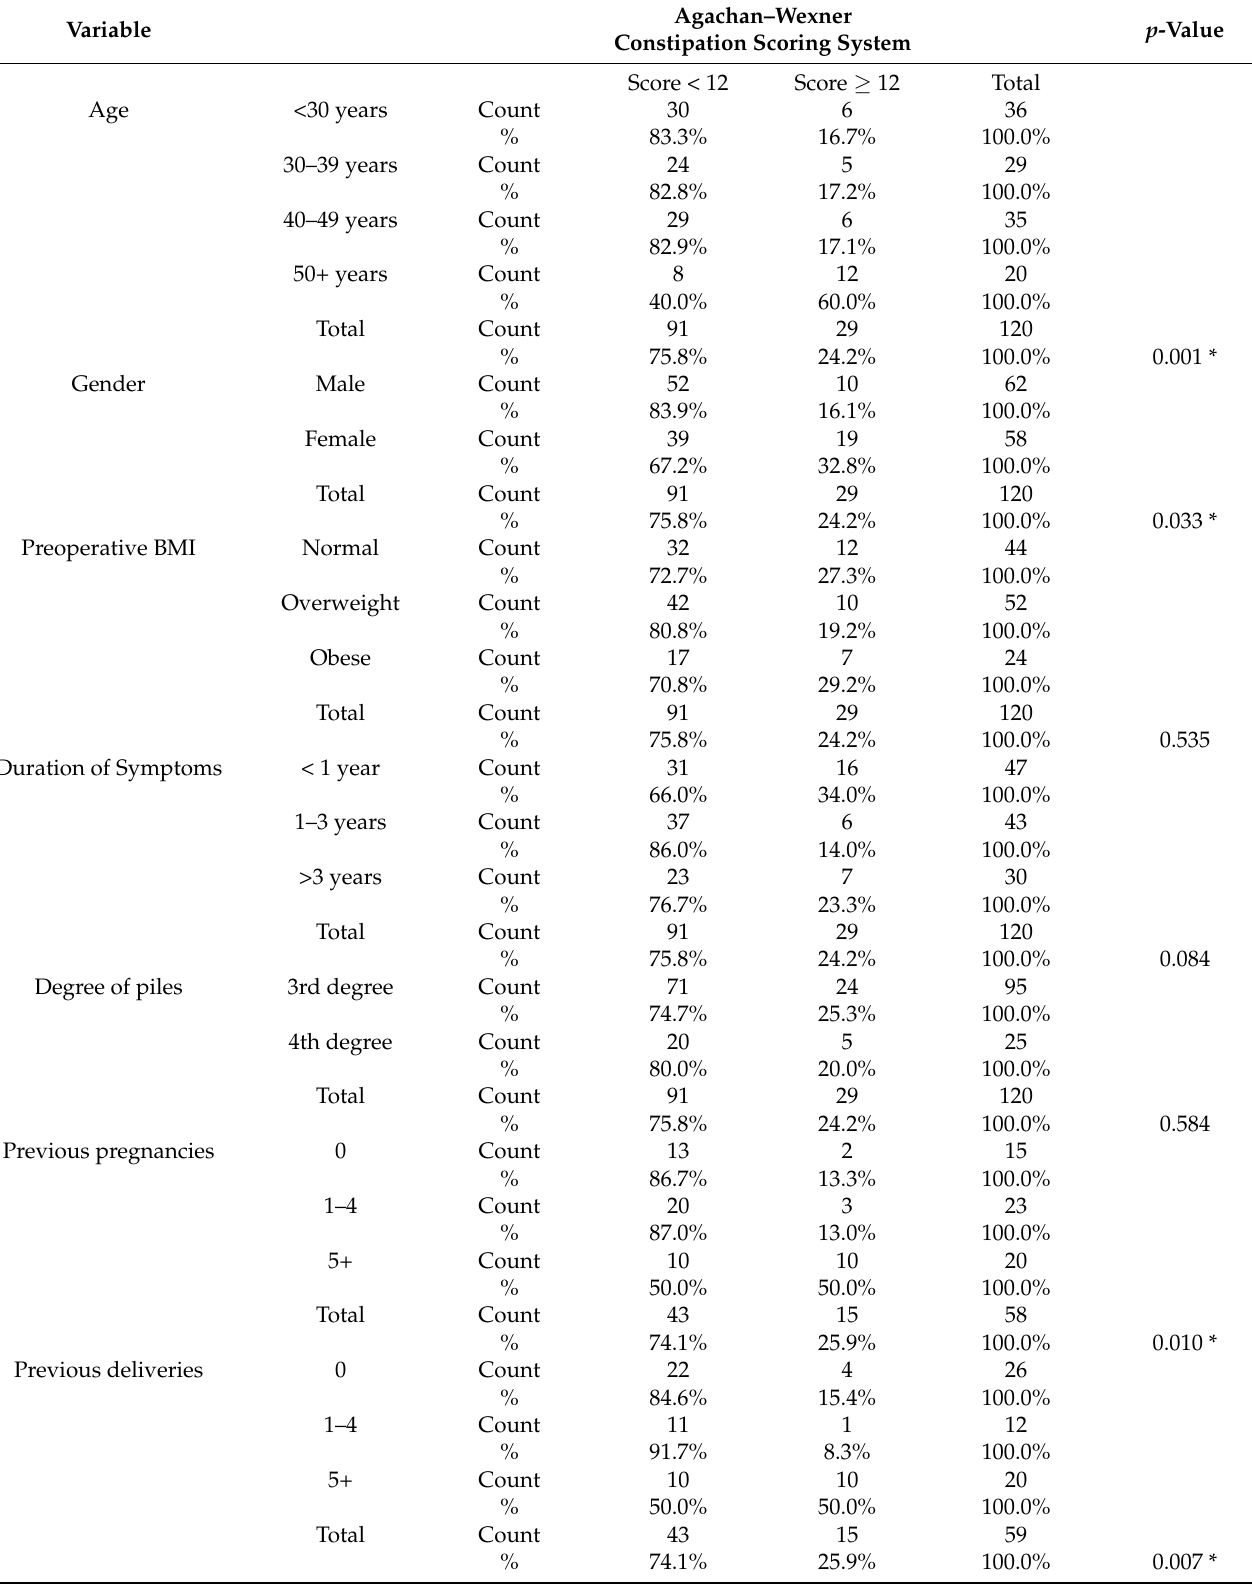
Table 2. Correlation of every item of pre-operative clinical and demographic data with the Agachan– Wexner Constipation Scoring